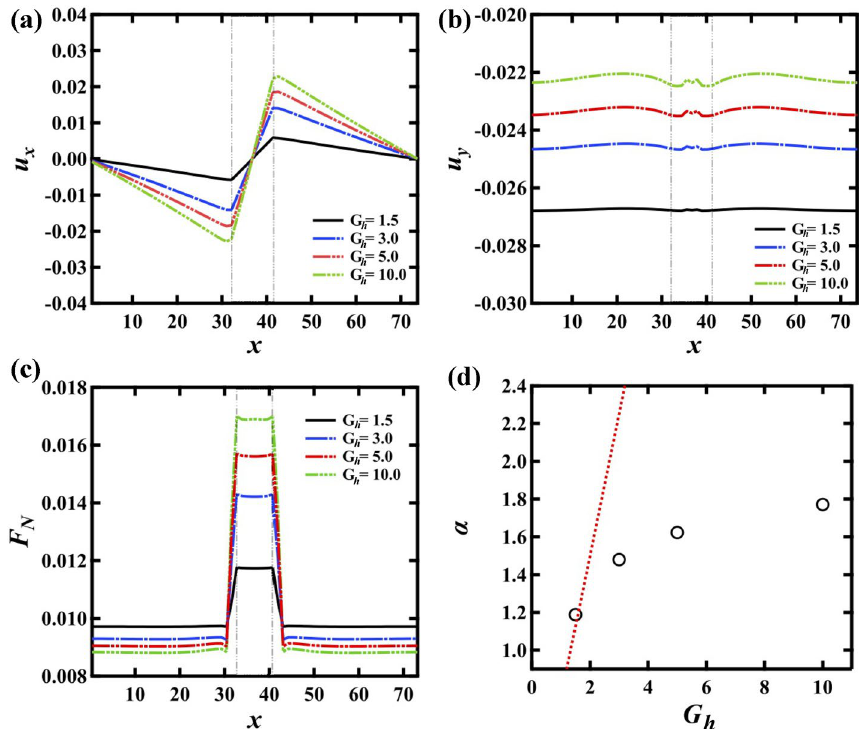
Figure 3. ( a ) Displacement in the x axis direction u x and ( b ) displacement in the y axis direction u y at n y = 12 . ( c ) The normal force F N on the bottom surface. ( d ) The ratio of the normal stress at G h region to that at G s region α . The dotted line in ( d ) corresponds to the theoretical prediction using the continuum approximation. α is much less than the theoretical prediction. This deviation comes from the density change of G h region.